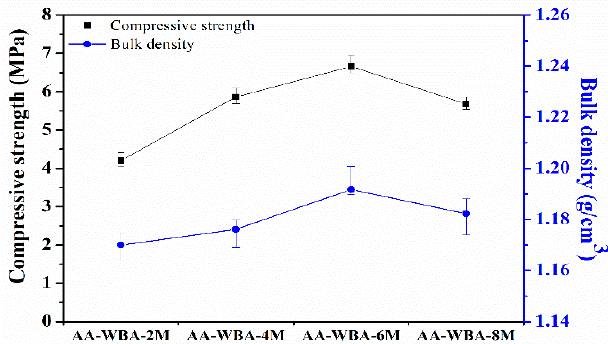
Figure 10. Bulk density and compressive strength of AA-WBA binders.